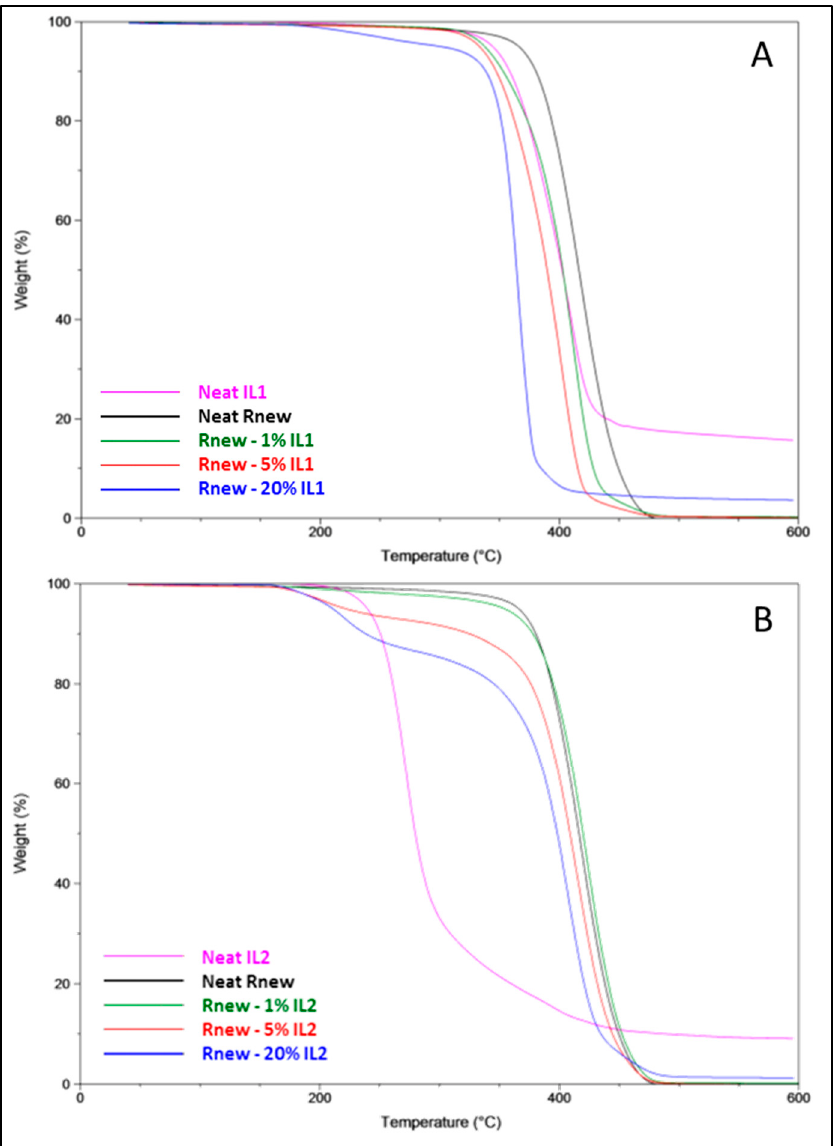
Figure 3. TGA thermograms for Pebax ® Rnew and Pebax ® Rnew composite membranes. ( A ) Samples containing IL1 (HdmimDMSIP); ( B ) Samples containing IL2 (OOMmimPF 6 ).